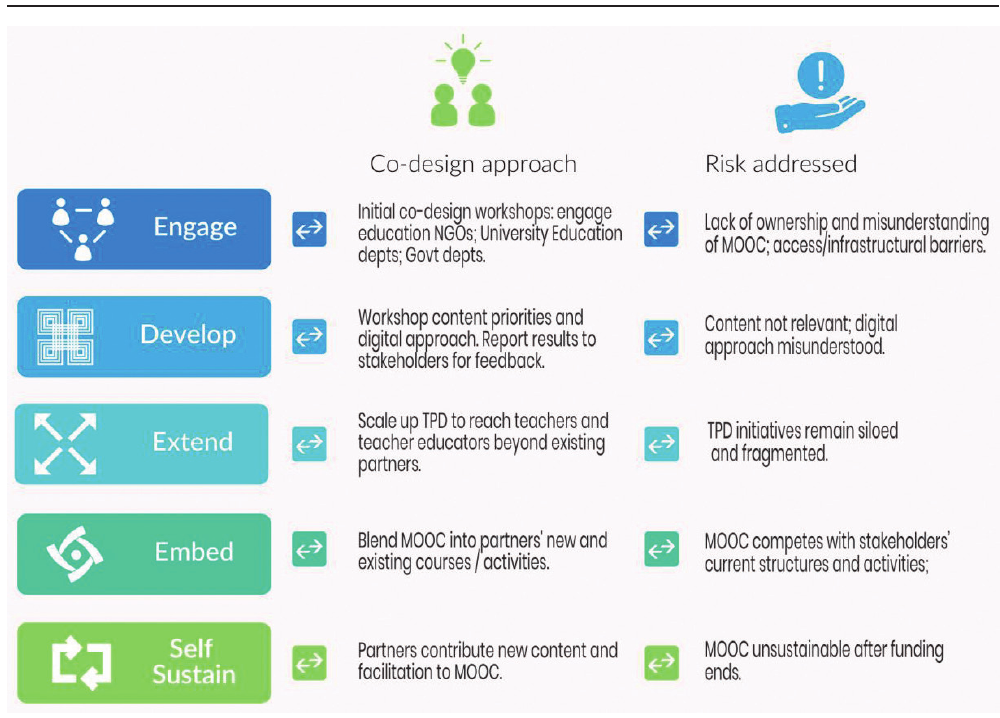
Figure 5: Theory of change for using MOOCs to scale up TPD in Lebanon